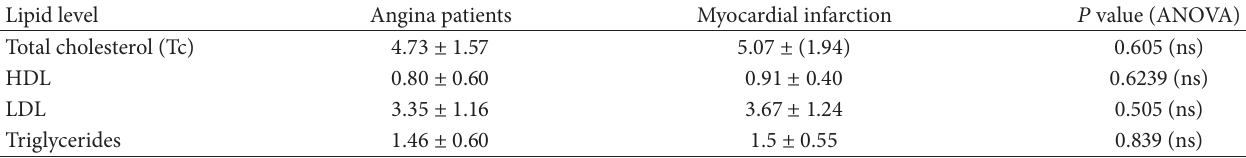
Table 5: Comparison of fasting lipid levels between participants with angina pectoris and those with myocardial